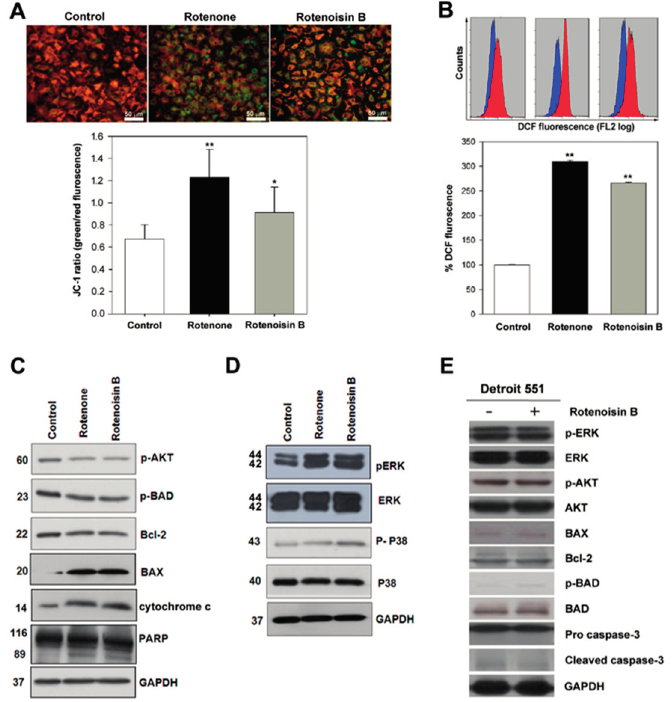
Figure 3. Mitochondrial transmembrane potential of rotenone and rotenoisin B by JC-1dye ( A ) analyzed with inverted fluorescence microscopy. The ratio of green to red fluorescence calculated; ( B ) Intracellular ROS detection using H2DCFDA (2 ′ ,7 ′ -dichlorodihydrofluorescein diacetate) by flow cytometry. Values were compared to the control and expressed as the means ± S.D of three independent experiments ( * p < 0.05, ** p < 0.01); ( C ) Immunoblot analysis of p-AKT (Thr 308), AKT, p-BAD (Ser 136), Bcl-2, BAX, cytochrome c and GAPDH; ( D ) Immunoblot analysis of pERK, ERK, p38, p-p38 and GAPDH after Huh-7 cells treatment with rotenone and rotenoisin B; ( E ) Immunoblot analysis of the molecules associated with cell proliferation and apoptosis in Detroit 551 cells after treatment with rotenoisin